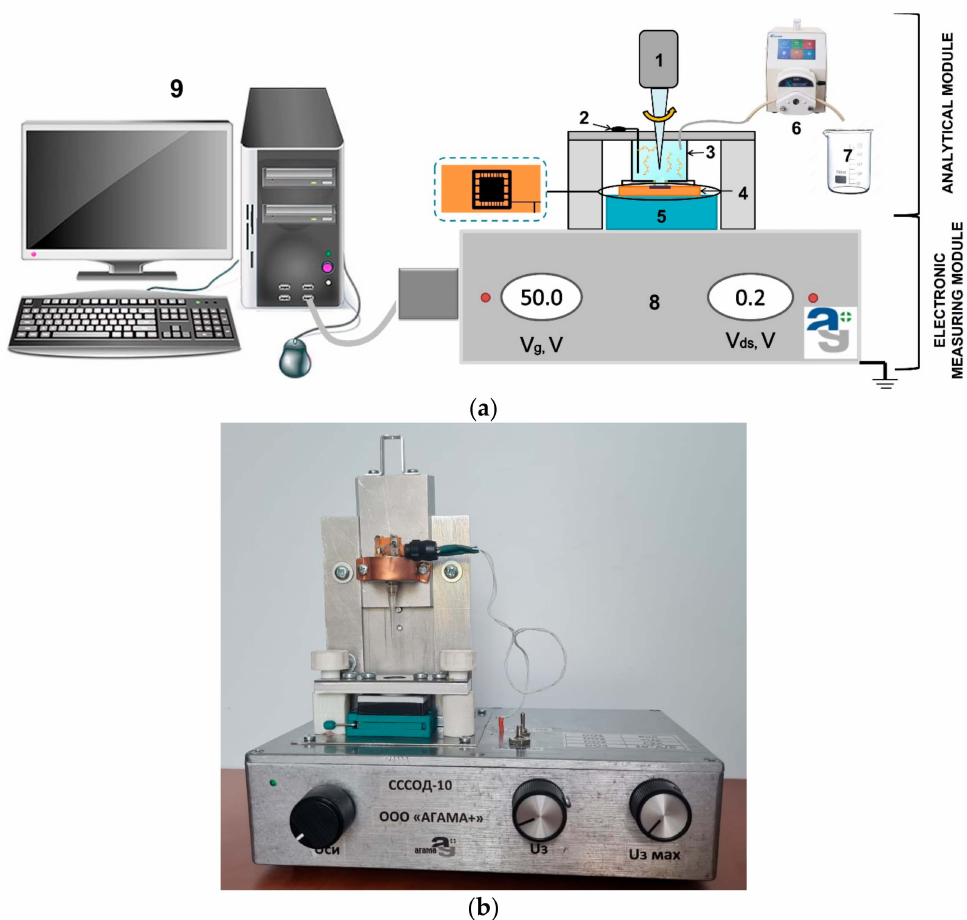
Figure 2. ( a ) A schematic view of the analytical module of a SOI-NW biosensor. Numbers indicate the key components of the module: (1) a stirrer; (2) a platinum electrode; (3) a measuring cell; (4) a SOI-NW chip; (5) a chip holder; (6) a peristaltic pump; (7) a waste container; (8) a ten-channel data collection and storage system, and (9) a PC. ( b ) A photographic image of the experimental setup.